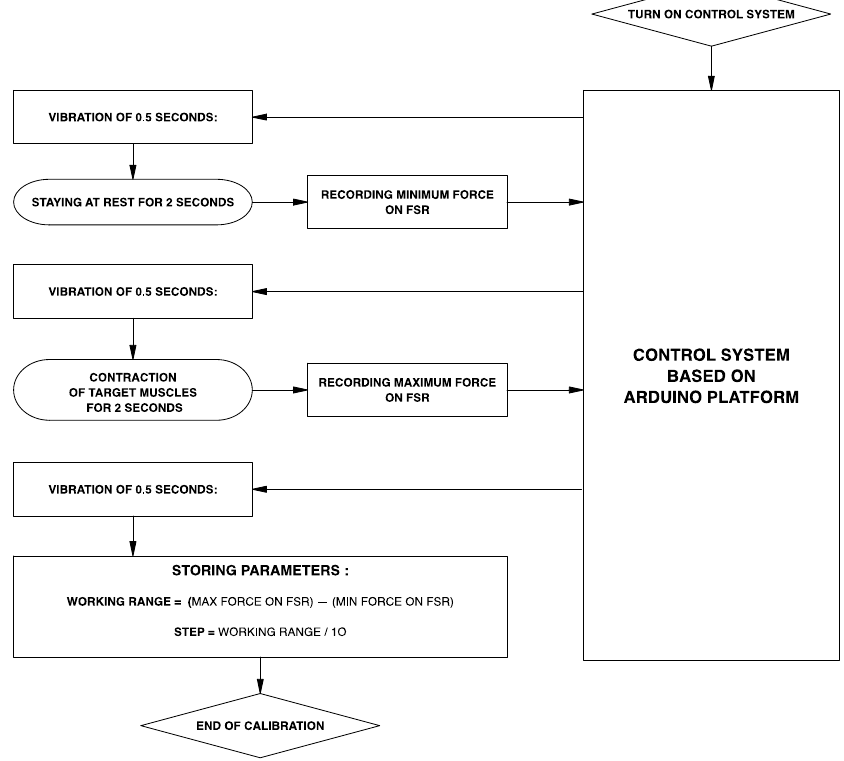
Figure 7. Flowchart describing the calibration phase of the control system. Proportional control is achieved by associating different levels of muscle contraction (from the minimum to the maximum of the FSR’s output voltages) to the rotation angle of the servomotor (from hand open, at 0 degrees, to hand closed, at 180 degrees). Even few levels (e.g., ten) allow a progressive and smooth hand closure.